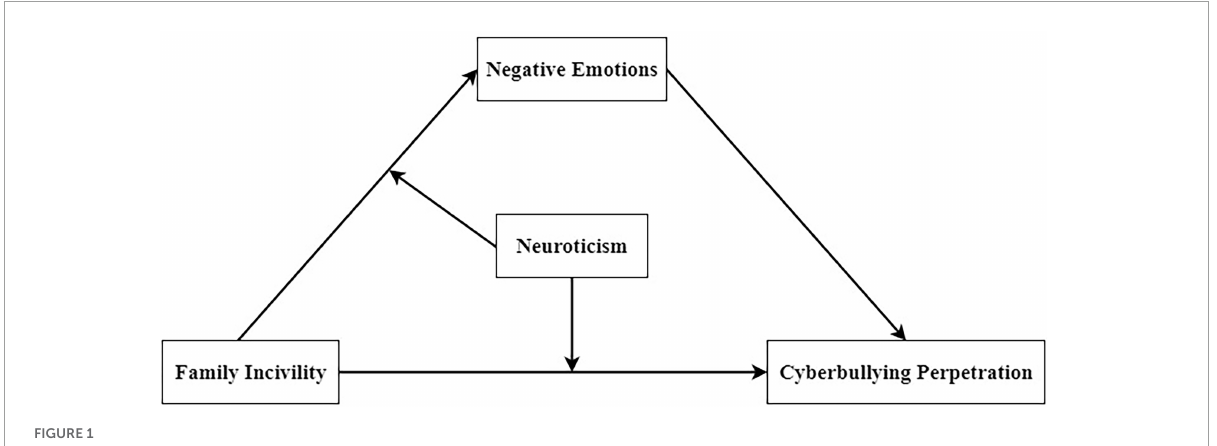
FIGURE1 The moderate mediating